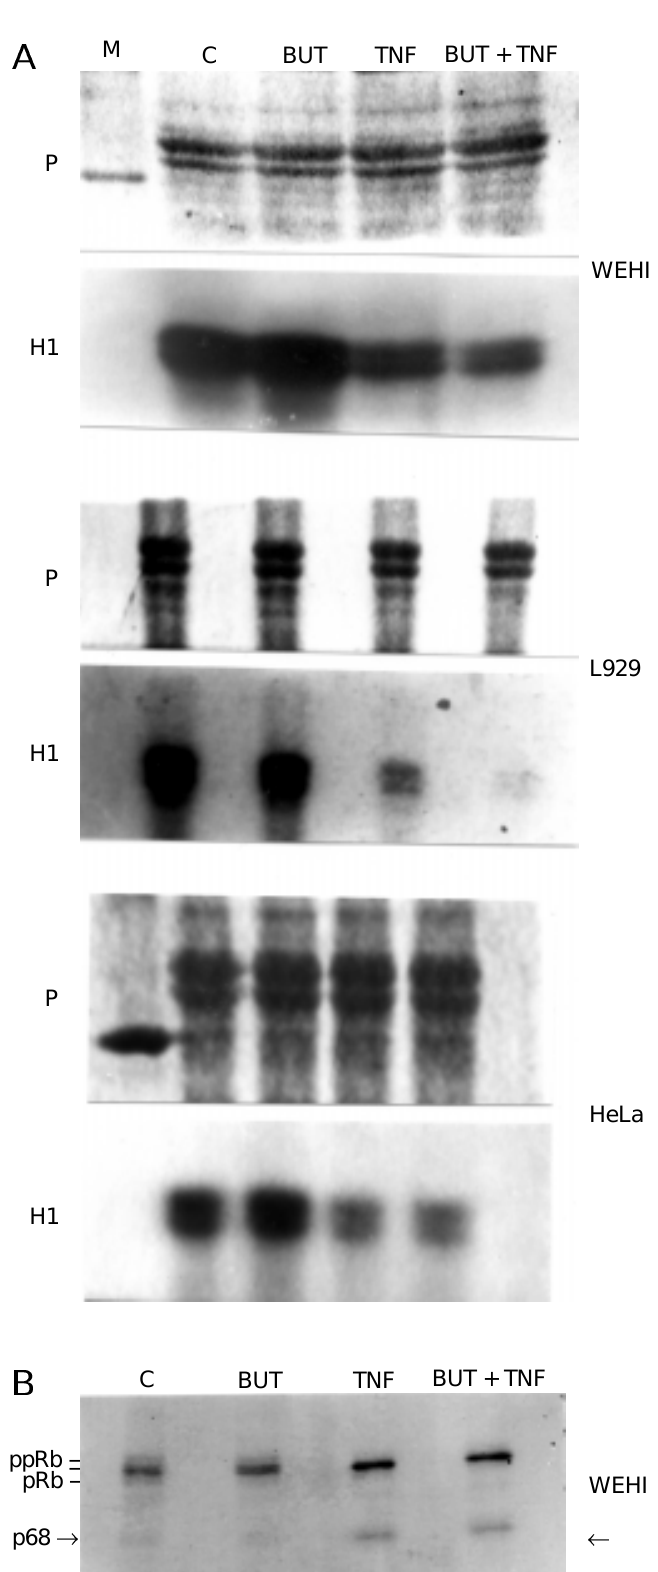
Figure 2 - A , Histone H1 kinase activity in the cell lysates of WEHI, L929 and HeLa cells incubated in the absence (C), in the presence of 100 µM butyrolactone (BUT), tumor necrosis factor (TNF) at 1, 5 and 100 ng/ ml, respectively, or both butyrolactone and TNF for 15 h (WEHI cells) or 24 h (L929 and HeLa cells). Equal amounts of proteins from cell lysates were incubated with 5 µg histone H1 and [ g - 32 ATP] and the level of after electrophoresis on 10% SDS/PAGE and autoradi- ography. Upper panel shows the pattern of protein bands (histone H1 and cell lysates) of Coomassie- stained gels, and the lower panel shows the autoradio- graph obtained with the dried stained gel after expo-